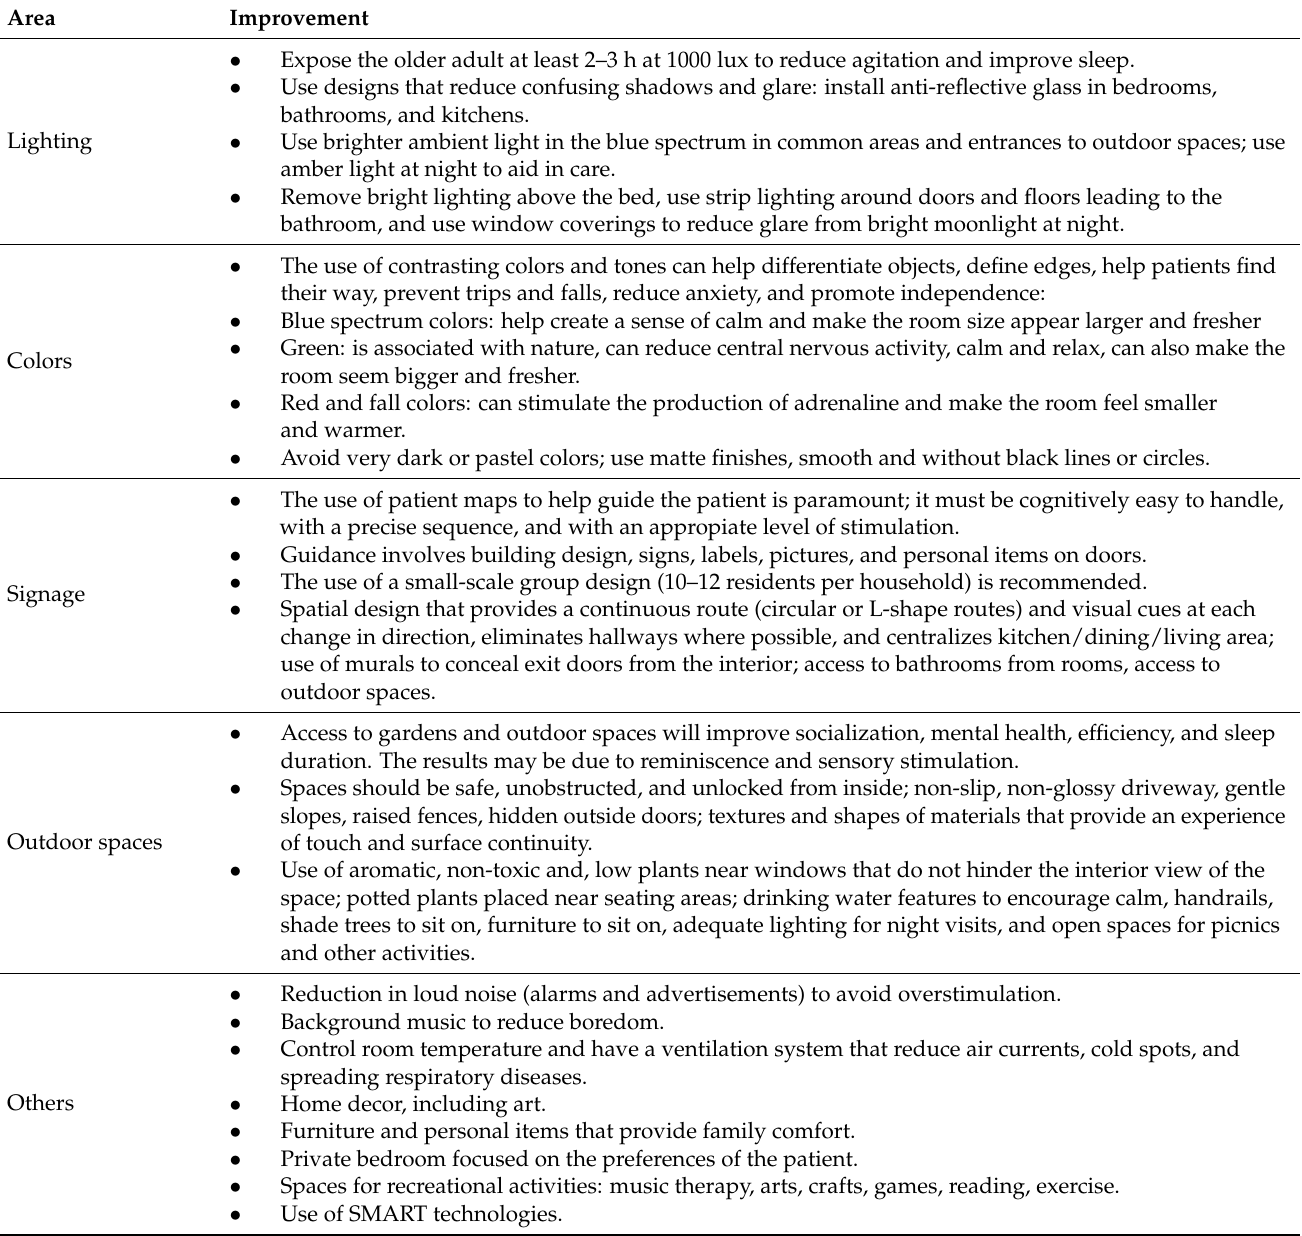
Table 2. Characteristics to improve in nursing